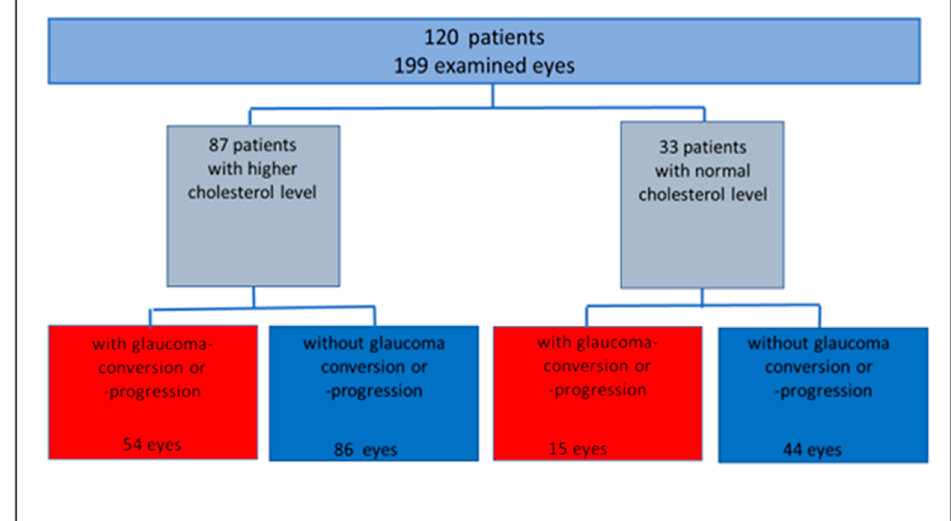
Figure 1. Study population, subgrouped according to cholesterol level, glaucoma conversion and progression rate (absolute number).